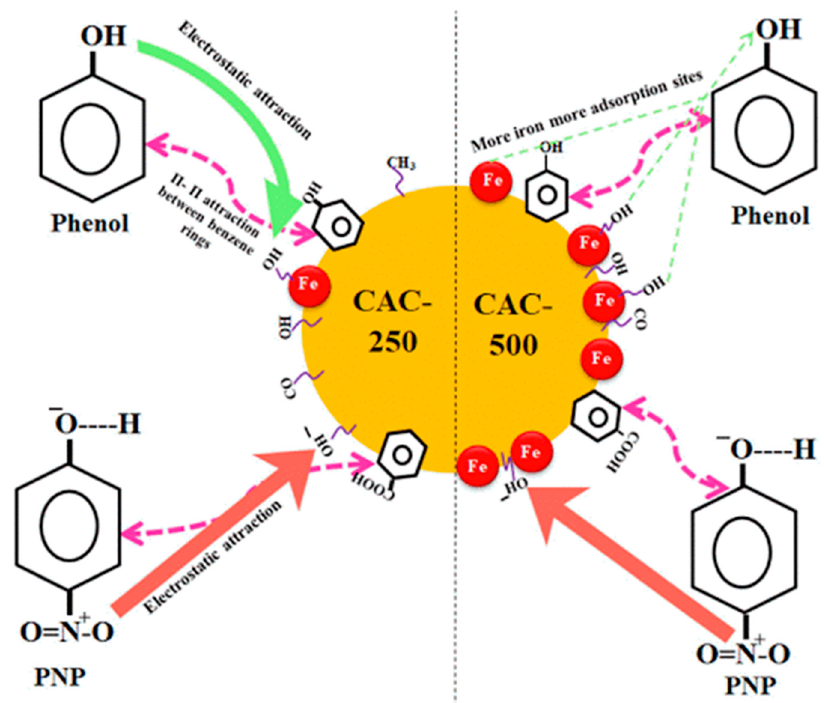
Figure 3. Mechanism for the adsorption of phenols onto activated carbons via hydrogen bonding and π – π interactions [125]. Copyright: Korean Society of Chemical Engineers (2020).